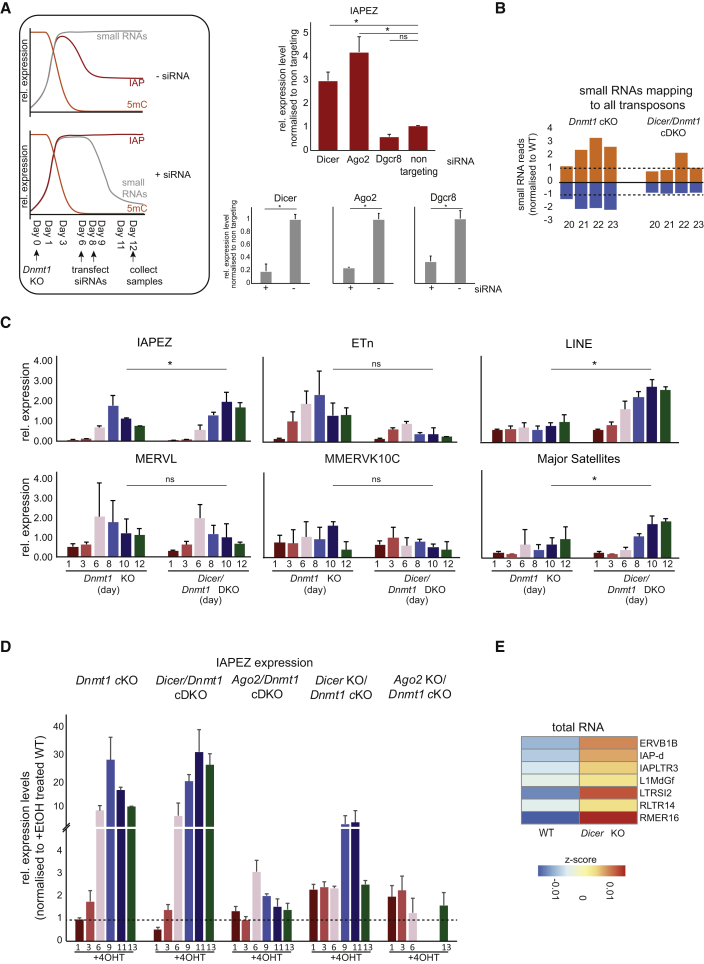
TEs Are Repressed by a DICER Mechanism(A) Knockdown (KD) of RNAi players. Left: schematic of siRNA KD in Dnmt1 cKO ESCs. The genome gets demethylated (5mC, orange) and IAPs get transcriptionally activated and resilenced (red) if small RNAs are present (gray); however, KD of the RNAi pathway will deplete small RNAs. Lower right: quantitative real-time PCR analysis showing KD efficiencies of Dicer, Ago2, and Dgcr8 upon treatment with siRNAs after Dnmt1 deletion. Upper right: expression of IAPs upon Dicer, Ago2, Dgcr8, or non-targeting siRNA transfection. The data are normalized to non-targeting control. Bars represent mean ± SD, n = 3. ∗p < 0.05, ∗∗p < 0.005, two-tailed Student’s t test.(B) Small RNA-seq of Dicer/Dnmt1 cDKO and Dnmt1 cKO ESCs. Sense (orange) and antisense (blue) small RNAs are separated by size and were mapped to all TEs. Reads were normalized to non-induced WT (Dicerfl/fl/Dnmt1fl/fl) ESCs.(C) Quantitative real-time PCR analysis of TE classes in ESCs following conditional Dnmt1 cKO or Dnmt1/Dicer cDKO by treatment with 4OHT or Dicer KO. Bars represent mean of two biological replicates with two technical replicates. Values were normalized to Atp5b and Hspcb, and major satellites were normalized to U1. ∗p < 0.05, ∗∗p < 0.005, two-tailed Student’s t test.(D) Quantitative real-time PCR analysis of IAPEz in the indicated ESC lines. Conditional deletions were induced by treatment with 4OHT for the indicated days. Values were normalized to Atp5b and Hspcb and are relative to the respective WT sample for each KO line, indicated by dashed line. Error bars represent mean ± SD; n = 3 for Dnmt1 cKO, Dicer KO/Dnmt1 cKO, and Ago2 KO/Dnmt1 cKO; n = 2 for Dicer/Dnmt1 cDKO and Ago2/Dnmt1 cDKO. Ago2 KO/Dnmt1 cKO time points days 9 and 11 were not collected.(E) Heatmap of unbiased hierarchical clustering of all TE classes responsive to Dicer KO. Heatmap depicts relative expression (Z score) of TEs upon Dicer KO.See also Figures S3 and S4I and Tables S2 and S3.